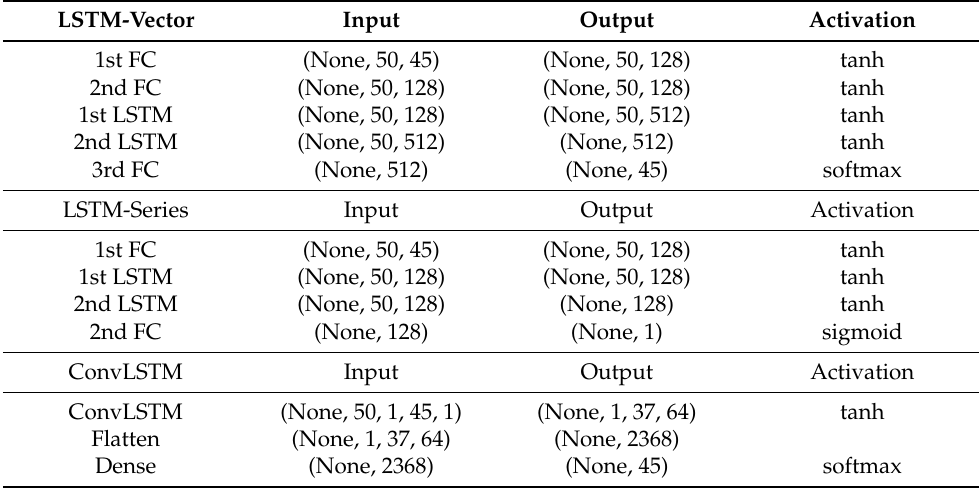
Table 3. Neural Network Structure: ConvLSTM and